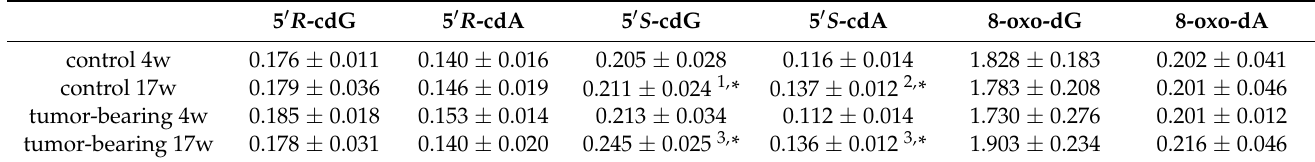
Table 1. The levels (lesions/10 6 nucleosides) of 5 (cid:48) R -cdG, 5 (cid:48) S -cdG, 5 (cid:48) R -cdA, 5 (cid:48) S -cdA, 8-oxo-dG, and 8-oxo-dA in the brain tissues of control SCID and tumor-bearing SCID, 4 weeks of age- and 17 weeks of age, respectively (mean ± standard deviation of six sample measurements).